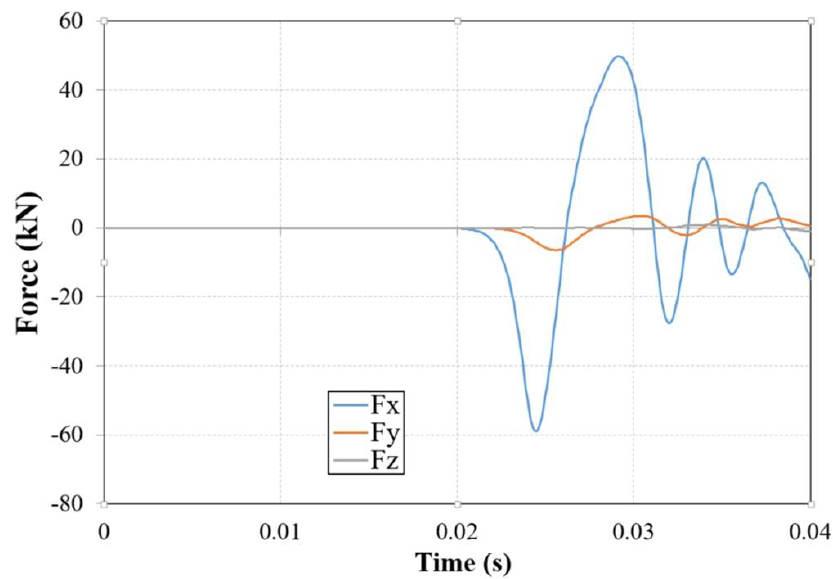
Figure 6. Components of compressive force acting on the obstacle at a distance of 10 m depending on time.